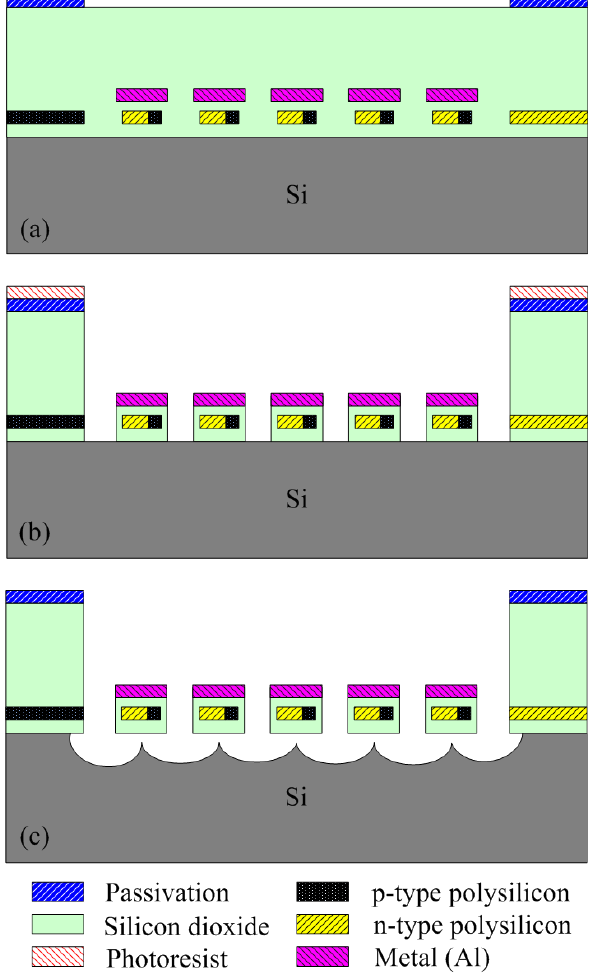
Figure 6. Process flow of the generator (a) after completion of the CMOS process;